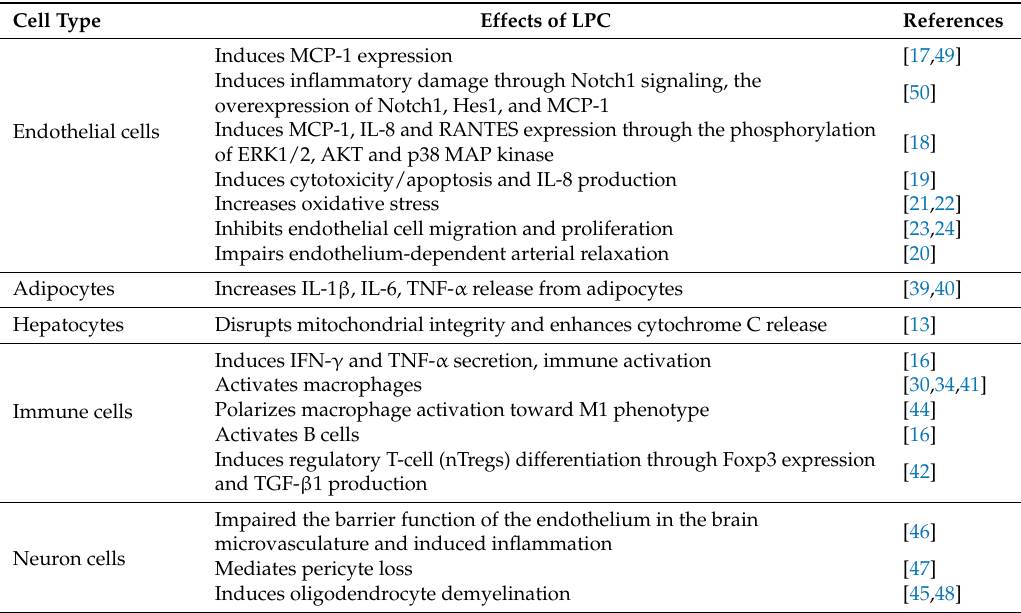
Table 1. Summary of reported effects of LPC on various cell